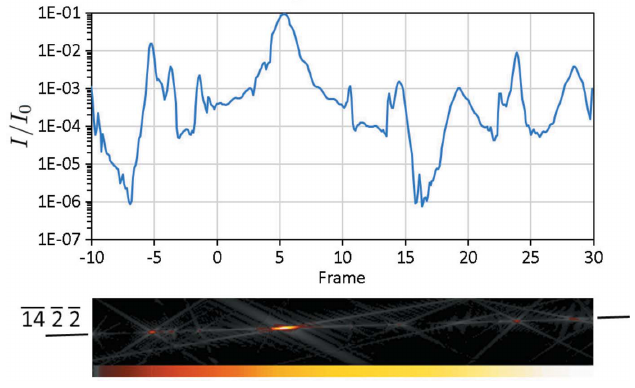
Figure 1 An illustration of the range of intensities that are obtained for the kinematically forbidden 14 2 2 reflection in silicon with a thickness of 180 nm in a dynamical simulation. The image underneath shows the corresponding LACBED pattern (see section